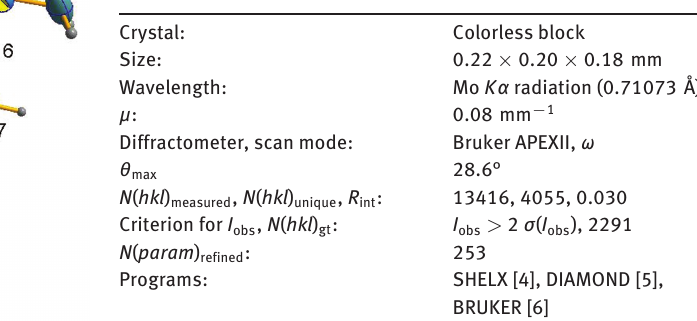
Table 1: Data collection and